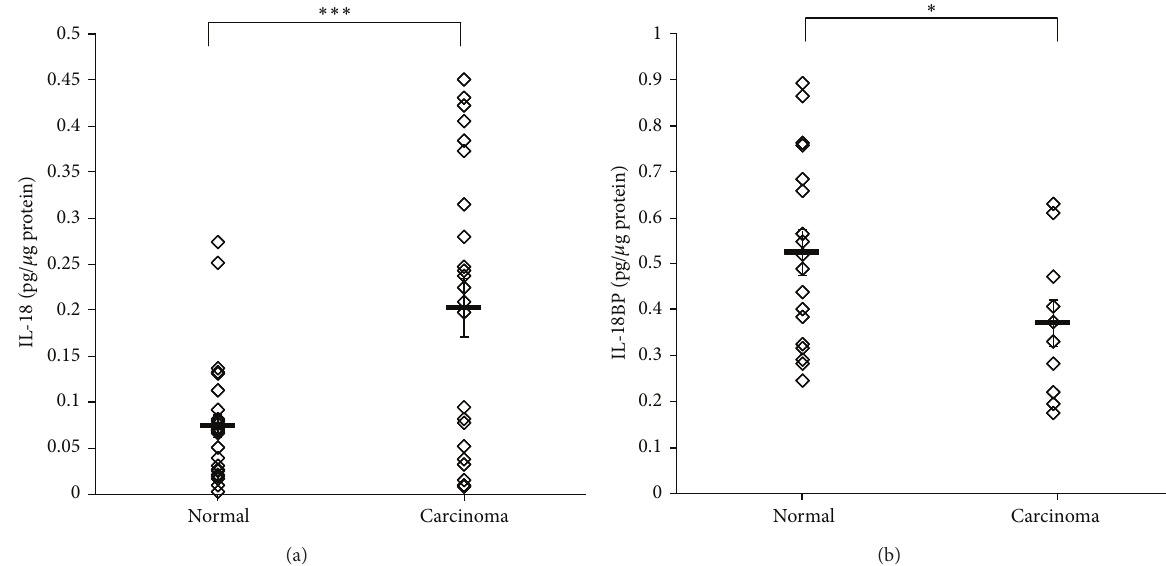
Normal and cancerous ovarian samples were homogenized and examined for IL-18, IL-18BP, and IL-18R mRNA levels by semiquantitative RT-PCR. The sum of the total samples tested ( 𝑁 ), the sum of the positive expression samples ( 𝑛 ), and the percentage of the positive samples of the total samples examined (%) are presented.